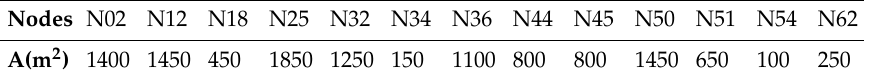
Table 7. New storm tank areas according to the zero-flooding solution of model SSR 2.